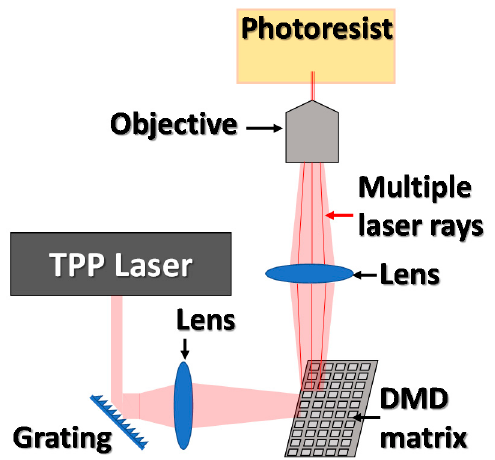
Figure 18. Visualization of the TPP coupled with a DMD matrix for simultaneous printing of multiple models.